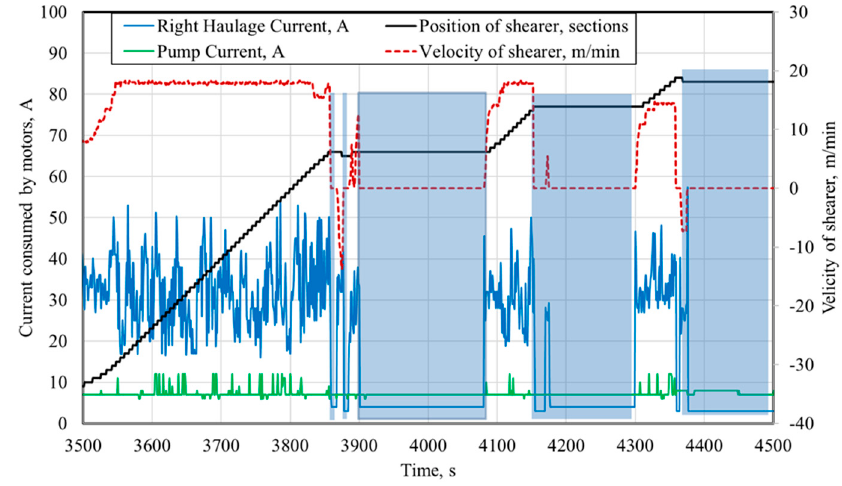
Figure 7. Time waveforms of the shearer’s speed and position in the longwall face and of the intensities of currents consumed by the right motors of the feed system and the hydraulic pump.